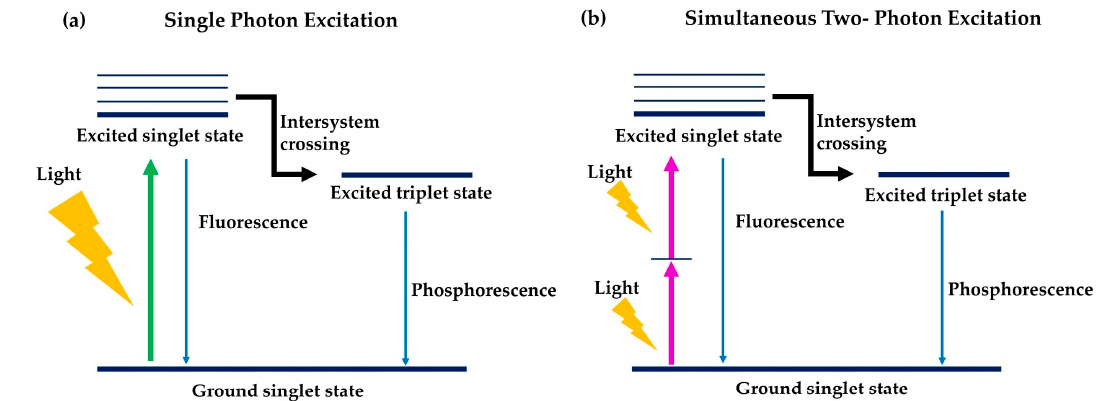
Figure 7. Comparison mechanism of PDT of single-photon excitation ( a ) and simultaneous two-photon excitation ( b